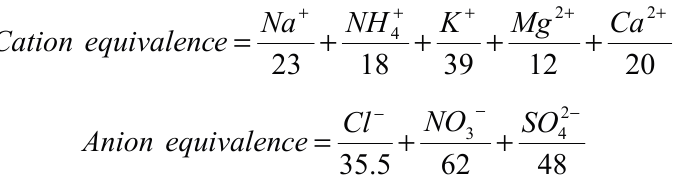
Figure 5. The mass concentrations of major water-soluble ions in PM 2.5 inside and outside the Pit No. 1 display hall during the summer and winter sampling campaigns in 2013. The charge balance between cation and anion was calculated using Equations (1) and (2). The correlations between cation and anion are summarized in Table